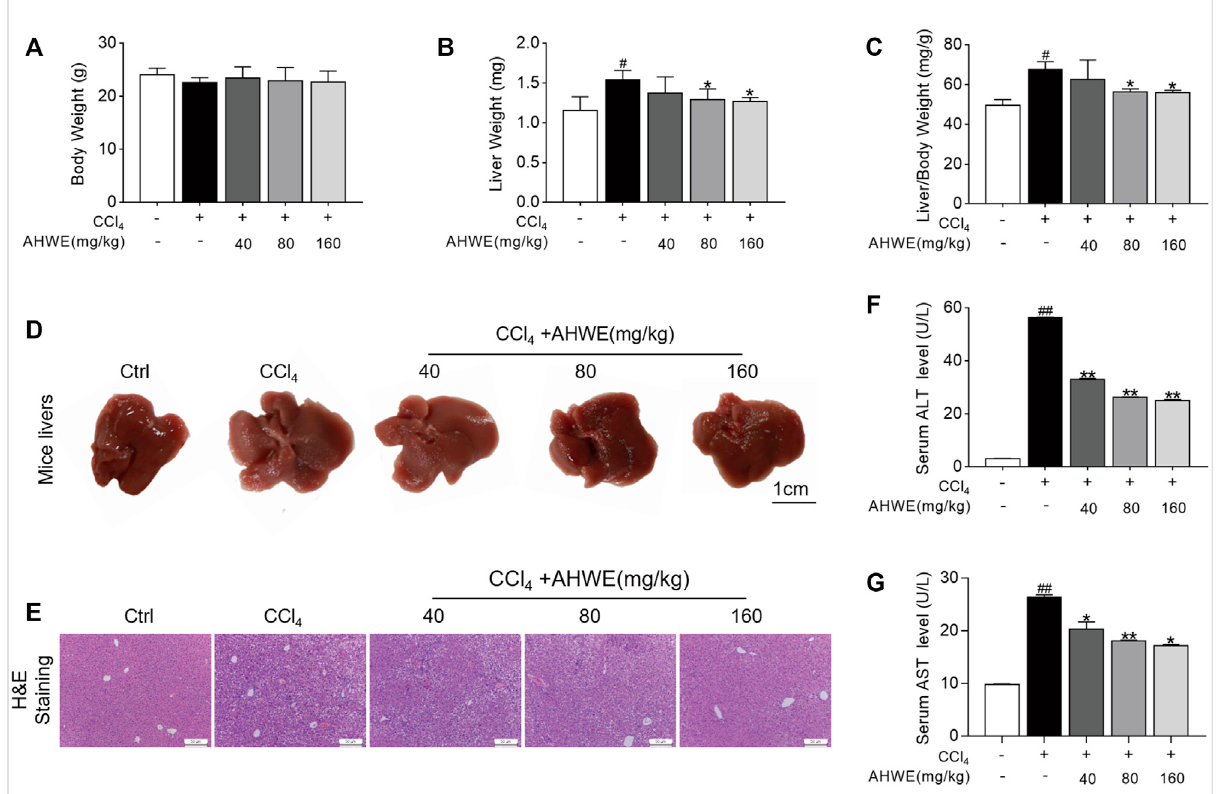
FIGURE 2 AHWE improved liver pathological damage of CCl 4 -induced HF mice. (A – C) Body weight, liver weight and liver/body weight index (%) in mice; (D) Gross examination of livers in mice (scale bar: 1 cm); (E) Histological examination of liver sections stained with H&E staining (scale bar: 100 μ m); (F,G) Determination of theserum levelsof ALT and AST with assay kits. For the statistics of each panel in this fi gure, data are expressed as mean ± SD ( n = 3). # p < 0.05 and ## p < 0.01 vs. control group; p p < 0.05 and pp p < 0.01 vs. CCl 4